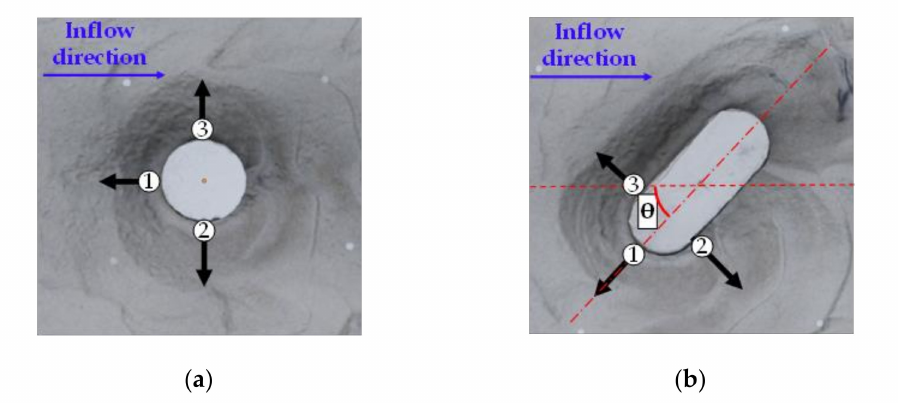
Figure 6. Measurement locations of local scour depth and extension for ( a ) Type 1 model and ( b ) Type 2